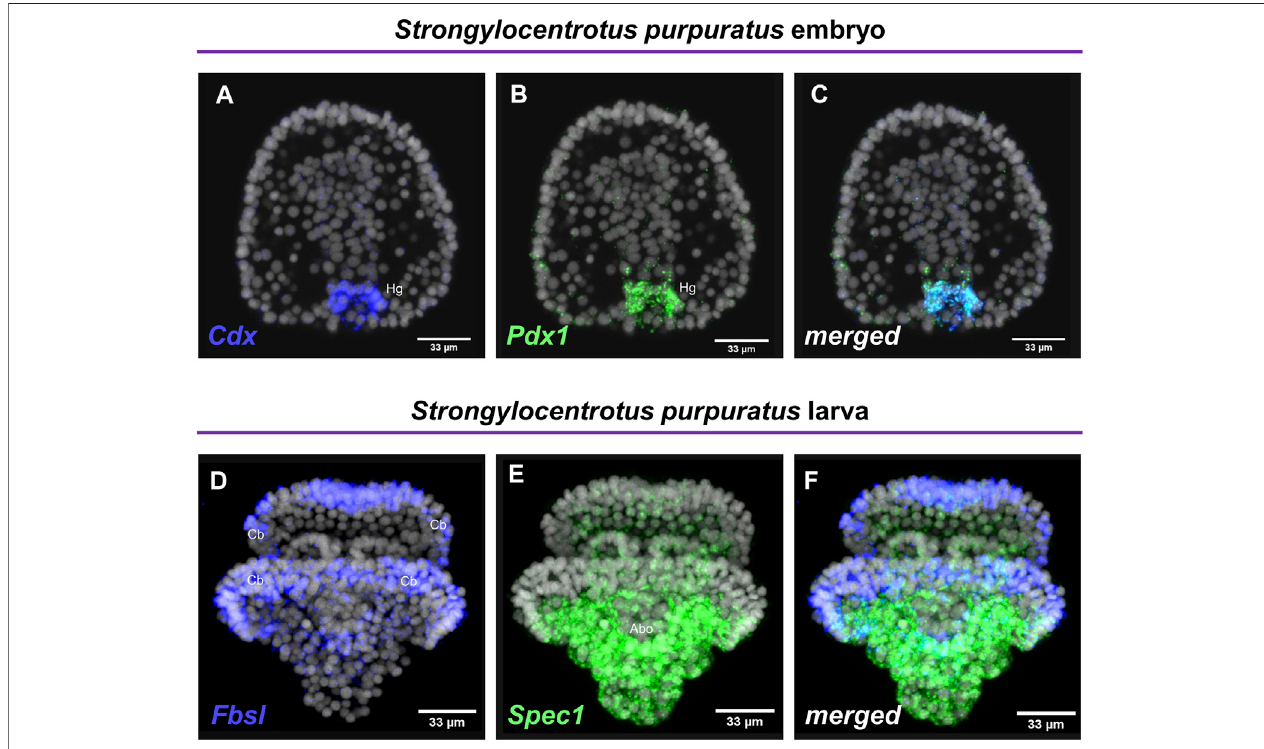
FIGURE 2 | Examples of double FISH. Double FISH of S. purpuratus embryos at gastrula stage using antisense RNA probes against Cdx (A) and Pdx1 (B) . The overlayofthetwochannelsisshowninpanel (C) .DoubleFISHof S.purpuratus pluteuslarvaeusingantisenseRNAprobesagainst Fbsl (D) and Spec1 (E) .Theoverlayof the two channels is shown in panel (F) . Nuclei are labelled with DAPI (in grey). All images are stacks of merged confocal Z sections. Abo, Aboral ectoderm; Cb, Ciliary band; Hg,